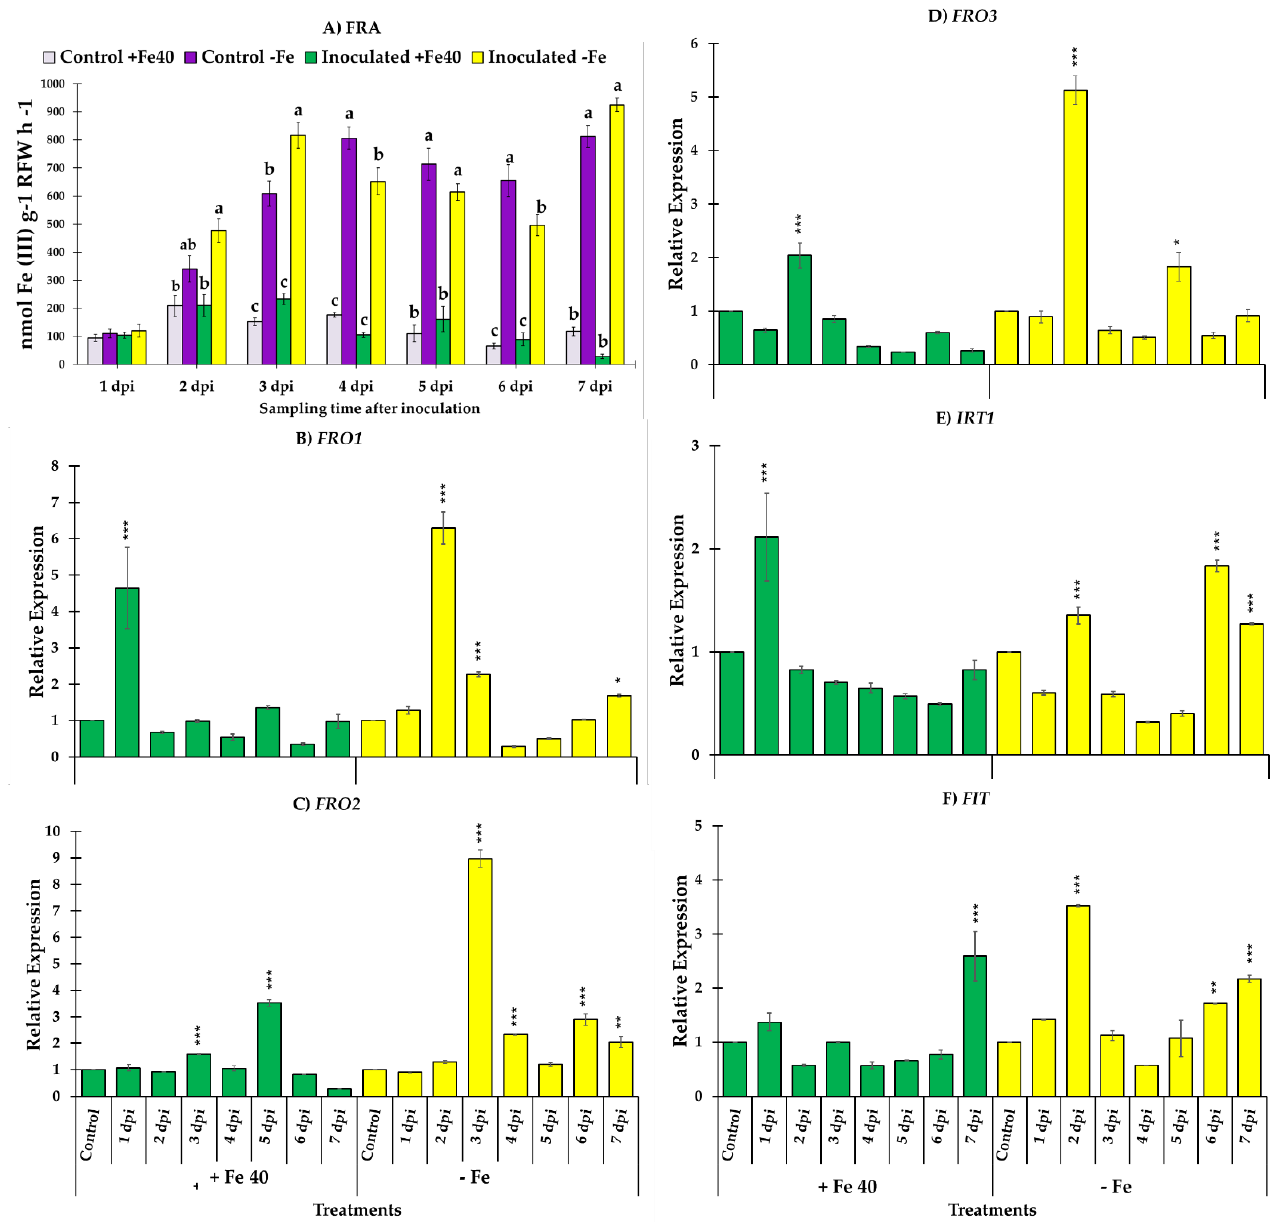
Figure 4. Evolution of FRA along seven days of observation and relative expression of FRO1 , IRT1 , FRO2 , FIT and HA1 in C. sativus roots. Four treatments were used, namely, (i) Control + Fe40 µ M (un- inoculated), (ii) Inoculated + Fe40 µ M, (iii) Control - Fe (un-inoculated) and (iv) Inoculated - Fe. The expression of control treatment for each nutritional condition is presented once, at the beginning of the graph, with the relative expression comparison method used, the control is always equal to 1. Data of gene expression represent the mean of three independent technical replicates, according to the Dunnett’s test, * ( p < 0.05), ** ( p < 0.01) or *** ( p < 0.001) over the bars indicate significant differences in relation to the control treatment. In the case of FRA, letter over the bars denote significant difference between plants inoculated and control plants analyzed by completely randomized ANOVA followed by a Tukey test ( p < 0.05).